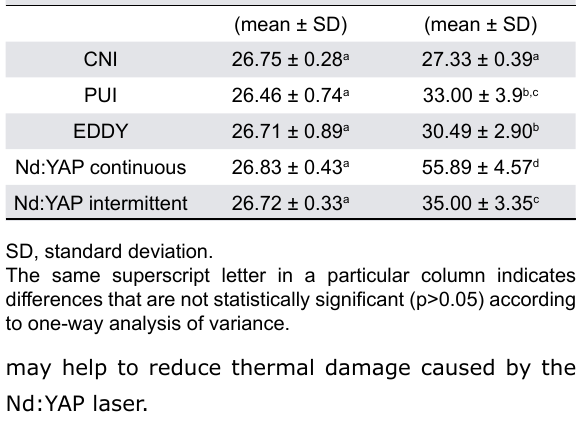
Figure 3- Quantitative analysis of dead bacteria in dentinal tubules. Graphs show the depths of dead bacteria of the dentinal tubules after the use of different irrigation protocols Table 1- Temperature change at the root surface in each Group Initial Maximum temperature (°C) temperature (°C)